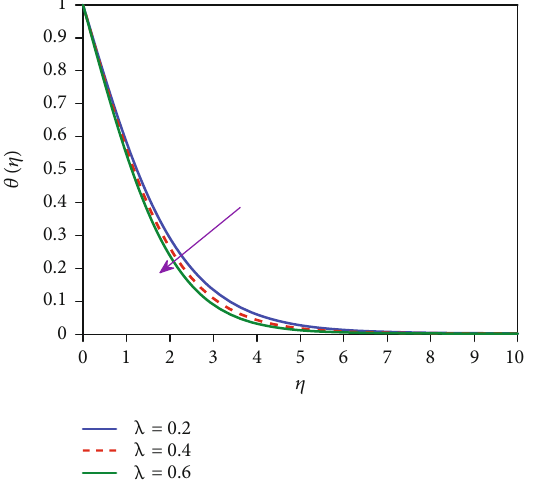
Figure 21: E ff ect of λ on the concentration ϕ ð η Þ .